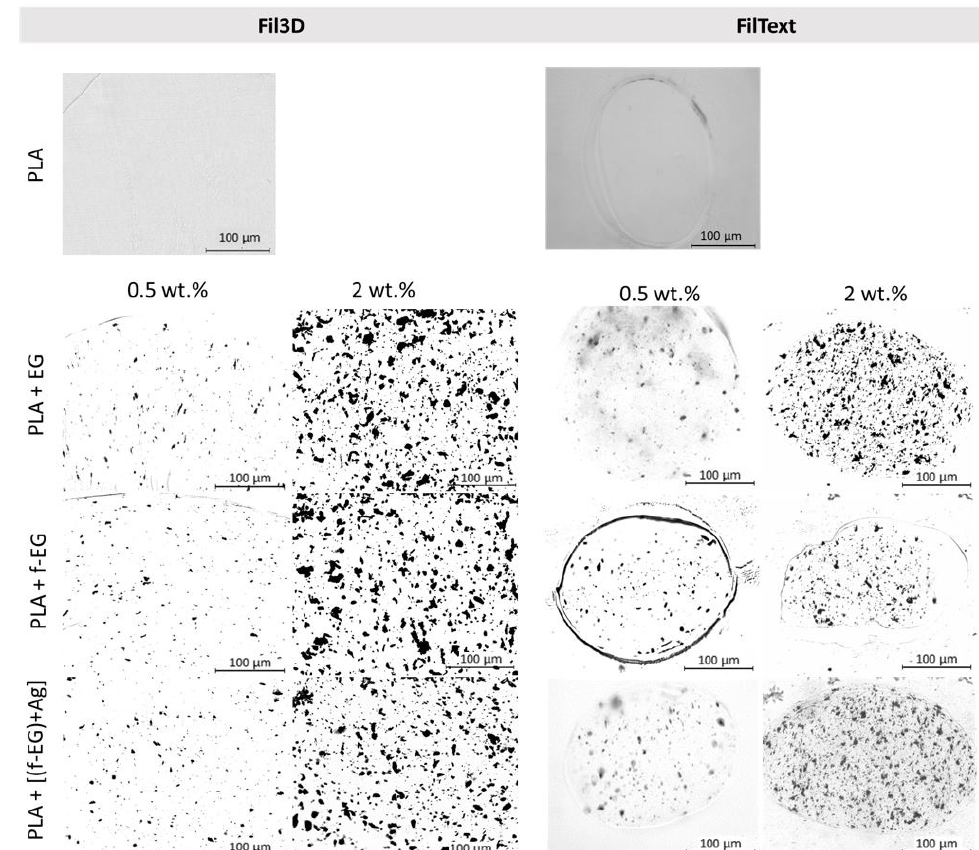
Figure 10. SEM images of Fil3D and FilText: PLA; PLA+2 EG; PLA+2 f-EG; PLA+2 [(f-EG)+Ag].